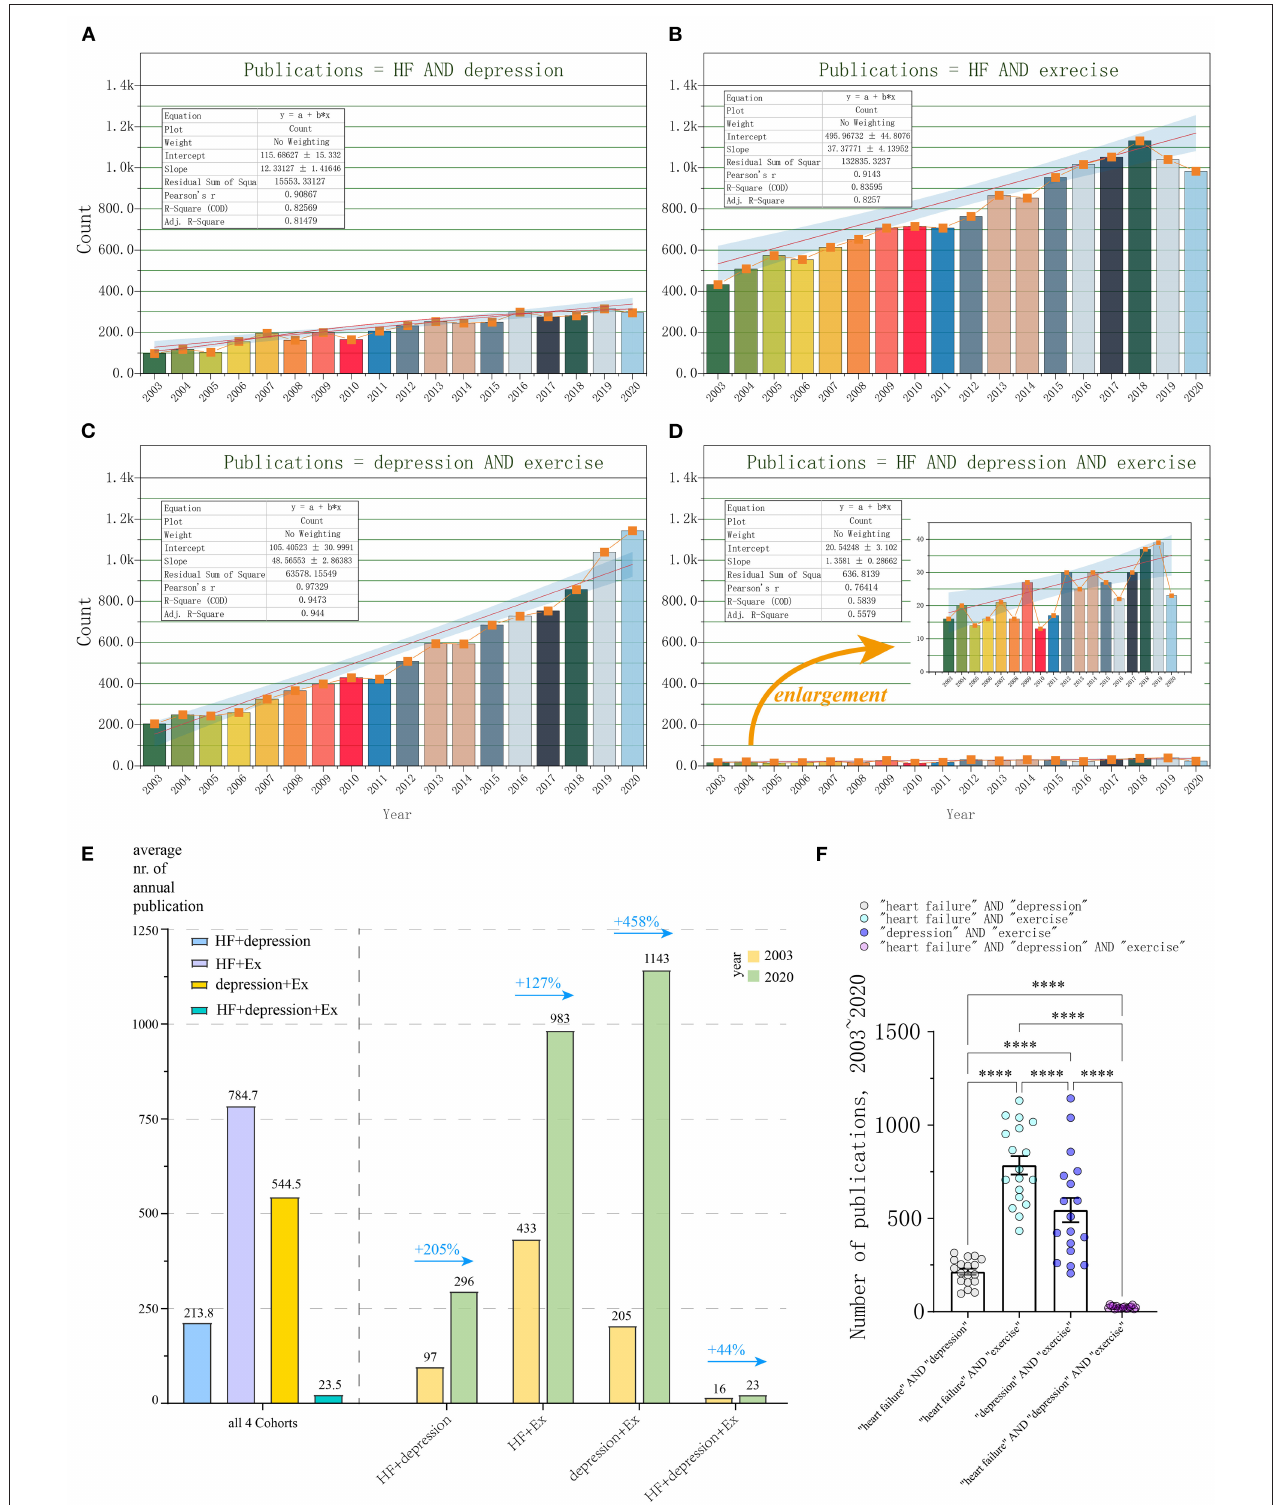
FIGURE 1 | Characteristic analysis of relative research interest (publication number and trends) from 01/2003 to 12/2020. (A) Cohort 1: publications matched with “heart failure” AND “depression” (HF + depression); (B) Cohort 2: “heart failure” AND “exercise” (HF + Ex); (C) Cohort 3: “heart failure” AND “depression” AND “exercise” (depression + Ex); (D) Cohort 4: “heart failure” AND “depression” (HF + depression + Ex); (E) Annual output analysis of four Cohorts; (F) Statistical analysis on the publication number of four Cohorts. Results of two-way ANOVAs are **** p < 0.0001, F = 122.5, for different comparisons.